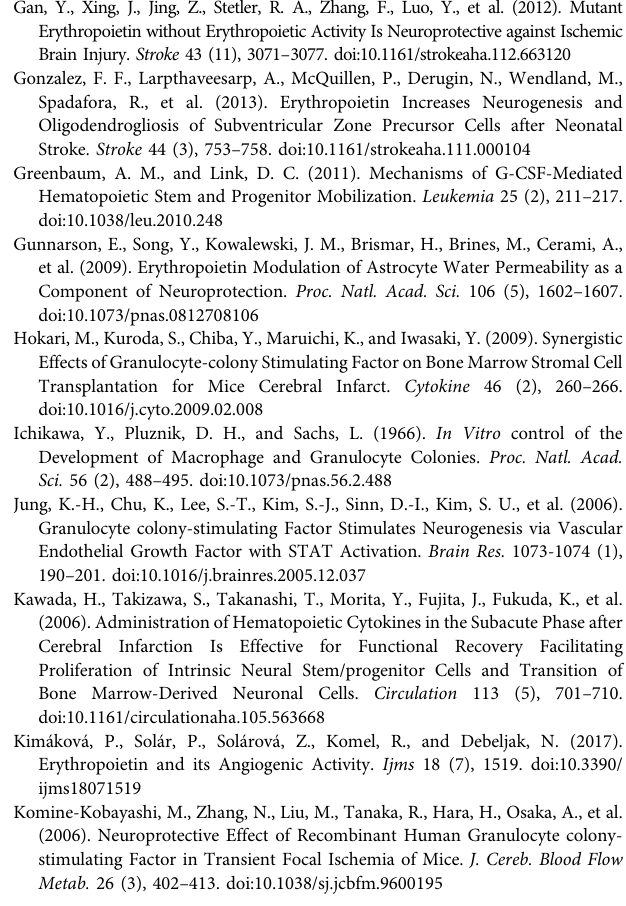
Supplementary Figure 1 | Meta-regression for NIHSS. Supplementary Figure 2 | Meta-regression for Barthel